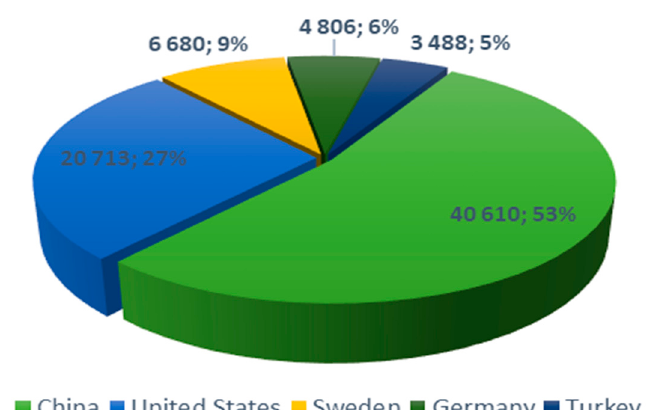
Figure 2. Worldwide leaders in the direct-use of geothermal energy including geothermal heat pumps in 2019 (MW). Source: Own study on the basis of: [34].